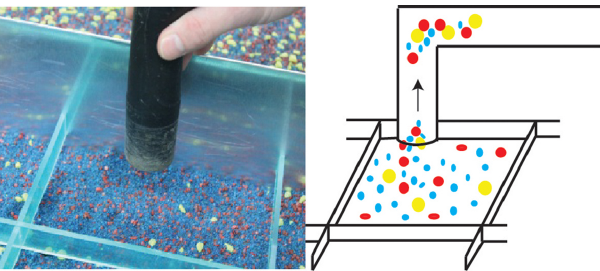
Figure 3. Experimental set-up. Side view of the delta progradation experiment during the removal of sediment layers and sampling for sieving purposes.